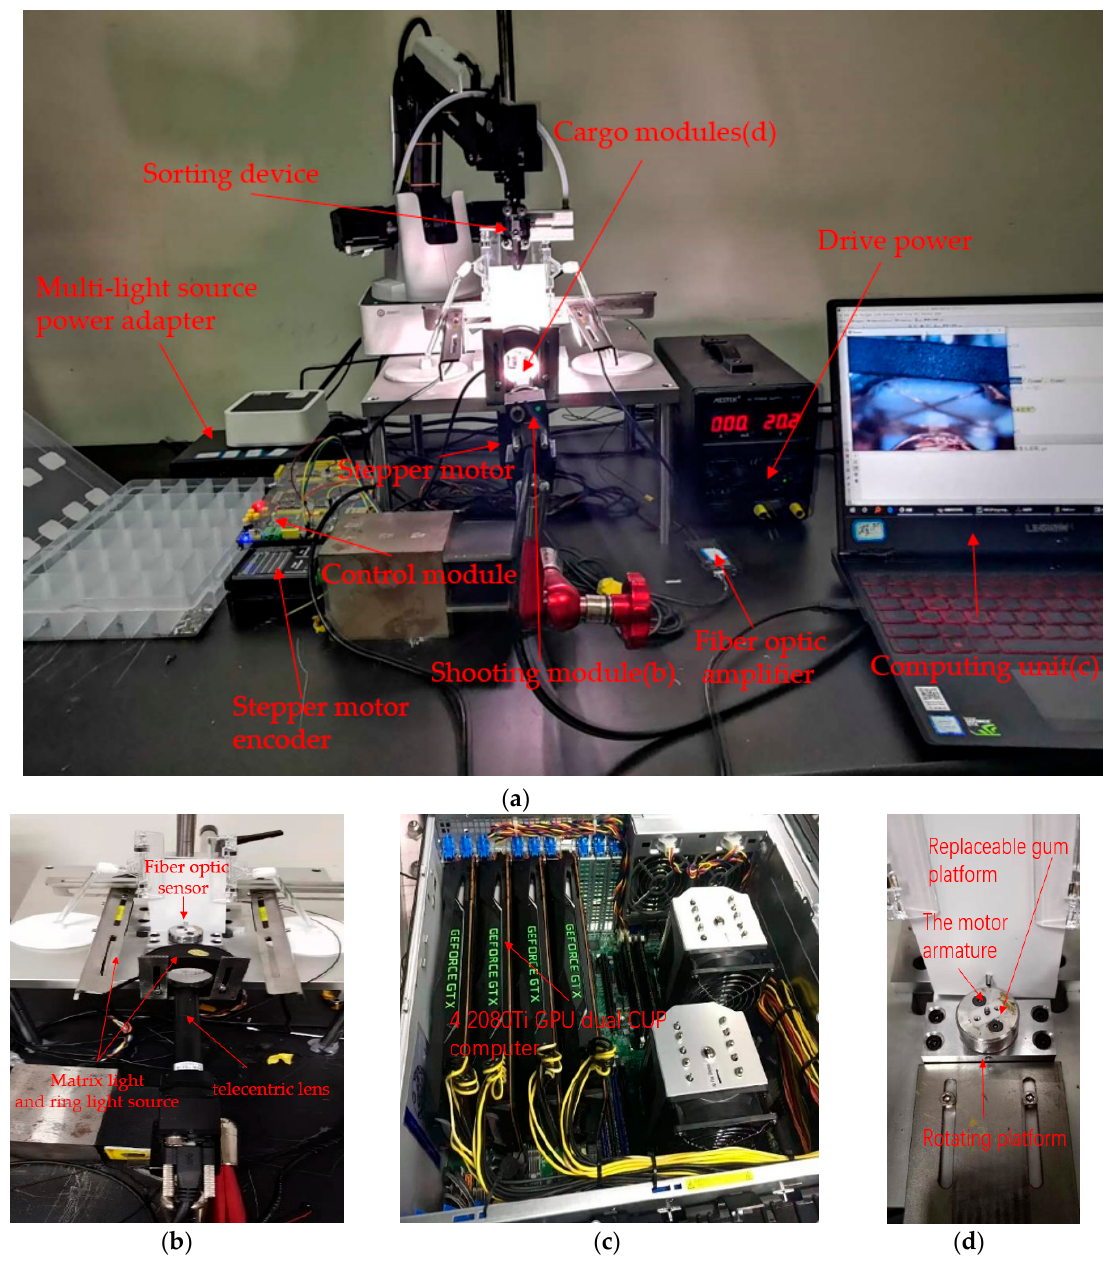
Figure 9. ( a ) The control module, sorting device and the light source group. ( b ) The matrix light and ring light source, as well as the laser source to provide a feedback signal for the stepping motor.